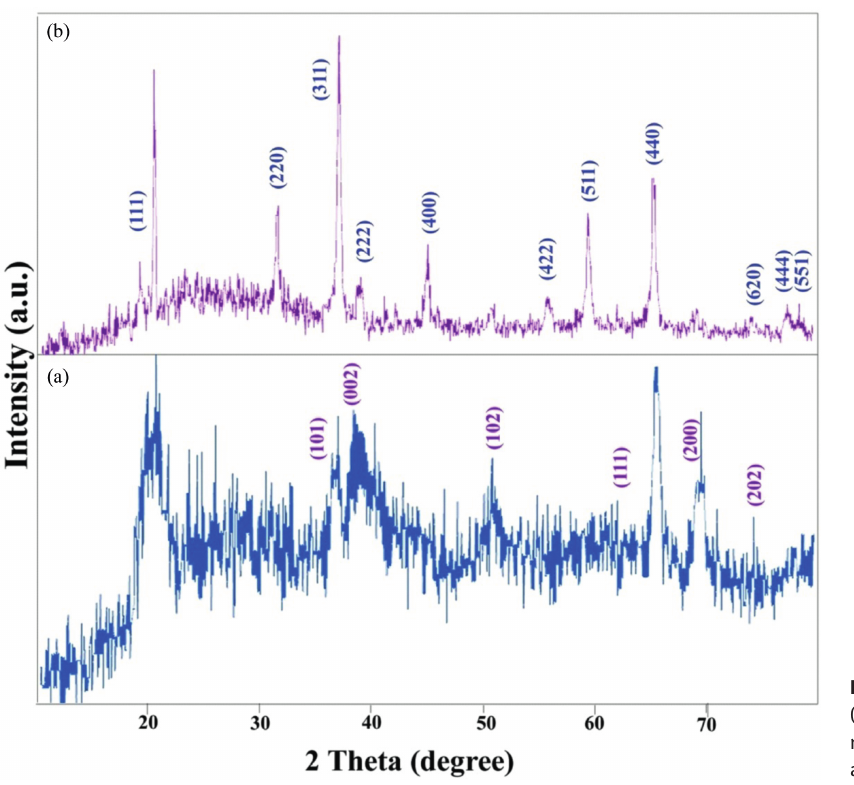
Figure 6: XRD patterns of (a) the as-product after hydrothermal reaction in pH = 8, (b) as-synthesized after calcinations.